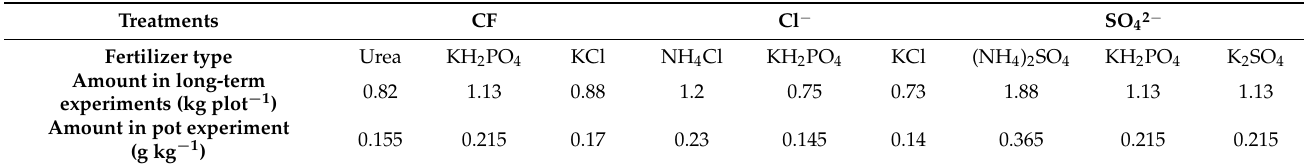
Table 1. Fertilizer amounts used in the three treatments in the long-term experiment (plot area: 25 m 2 ) and the pot experiment.